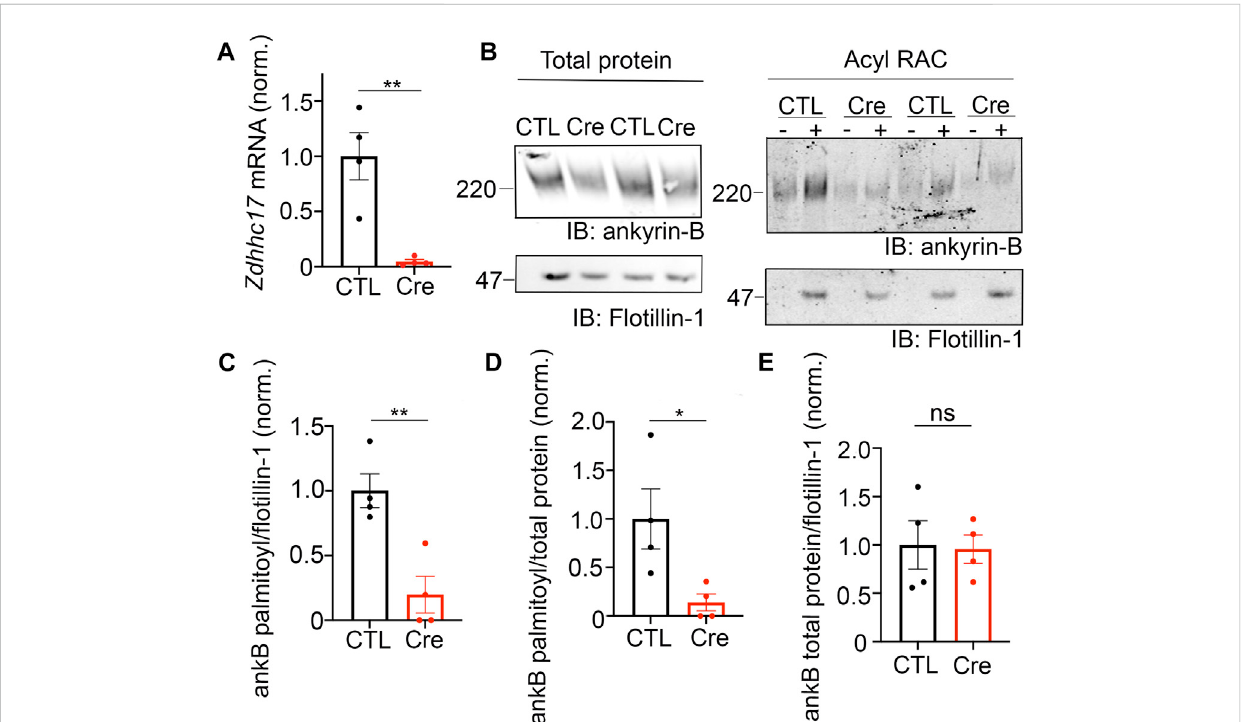
FIGURE 3 zDHHC17 is a critical regulator of endogenous ankyrin-B palmitoylation in cultured hippocampal neurons from. (A) . Zdhhc17 mRNA levels in cultured hippocampal neurons from Zdhhc17 mice transduced with either a β -galactose control adenovirus or Cre-recombinase adenovirus for 10 days prior to sample collection for RT-PCR analysis ( n = 4). Zdhhc17 mRNA was decreased by ~95% in the Cre-recombinase condition compared to control. ** p < 0.01; Student ’ s t-test (unpaired). (B) . Representative western blot showing total protein levels of endogenous ankyrin-B ( left ) and palmitoylation levels of endogenous ankyrin-B ( right ) from lysates of fl oxed Zdhhc17 hippocampal neurons transduced with either a β -galactose control adenovirus or Cre-recombinase adenovirus for 10 days before Acyl-RAC processing (N = 4). Both protein ( left ) and palmitoylation ( right ) levels of endogenous ankyrin-B are immunoblotted with an antibody against ankyrin-B for all conditions. Palmitoylation of ankyrin-B is strongly detected in a hydroxylamine dependentmanner ( ’ +HA ’ lane) from cultures infected with the control virus, but isgreatly reduced in culturesinfected with theCrevirus, asdemonstratedbythelowerankyrin-Bsignalintensity inthe ‘ +HA ’ lane. (C) .Quanti fi edendogenousankyrin-B S -palmitoylationnormalizedto fl otillin-1 levels from the Acyl-RAC fractions and further normalized to control virus. Data from N = 4 independent replicates per condition from (A) . ** p < 0.01; Student ’ s t-test (unpaired). (D) . Quanti fi ed endogenous ankyrin-B S -palmitoylation normalized to total ankyrin-B protein levels for each condition, and further normalized to control virus. Data from N = 4 independent replicates per condition from (A) . ** p < 0.05; Student ’ s t-test (unpaired). (E) . Quanti fi